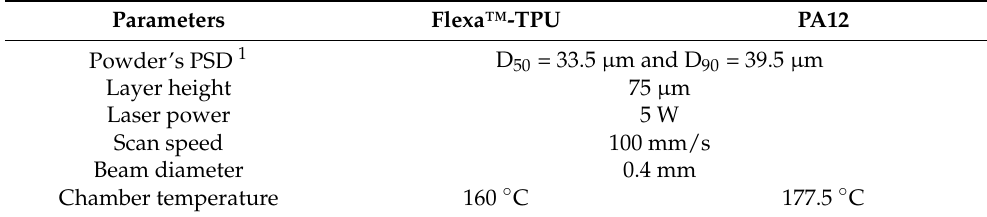
Table 2. Main parameters of SLS 3D printing process for the external covers.